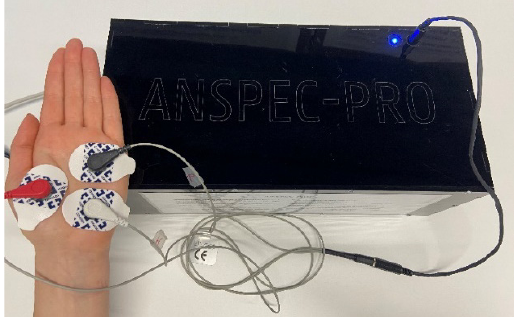
Figure 2. ANSPEC-PRO measurement device and electrodes placement.